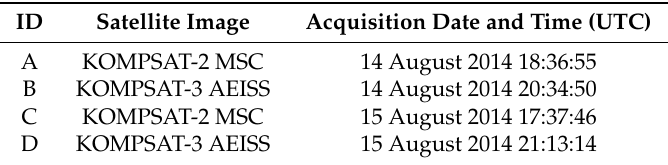
Table 2. Details for satellite image acquisition.